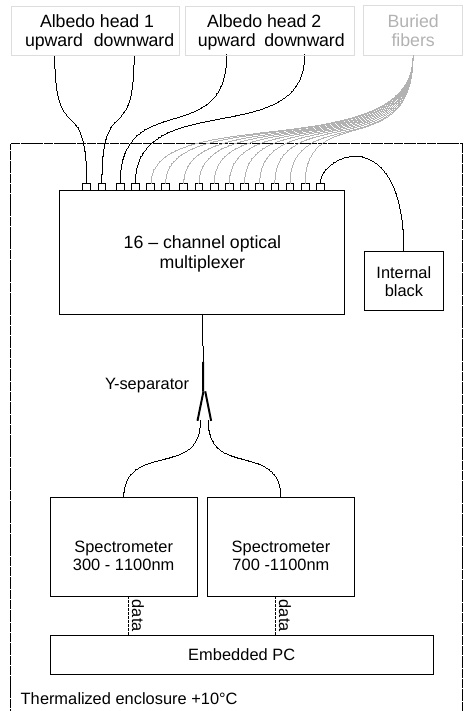
Figure 6. Principle of Autosolexs. The dotted rectangle represents the thermalized container that is buried in the snow. The plain curved lines represent fiber optics, the fibers buried in snow (gray) are not used in the present study.